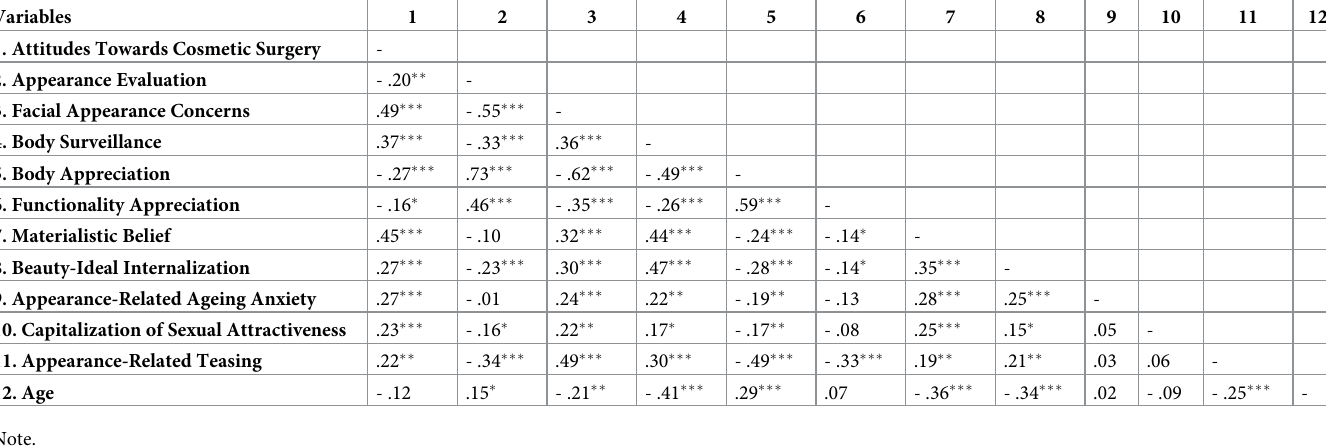
Table 4. Correlations between variables among Dutch